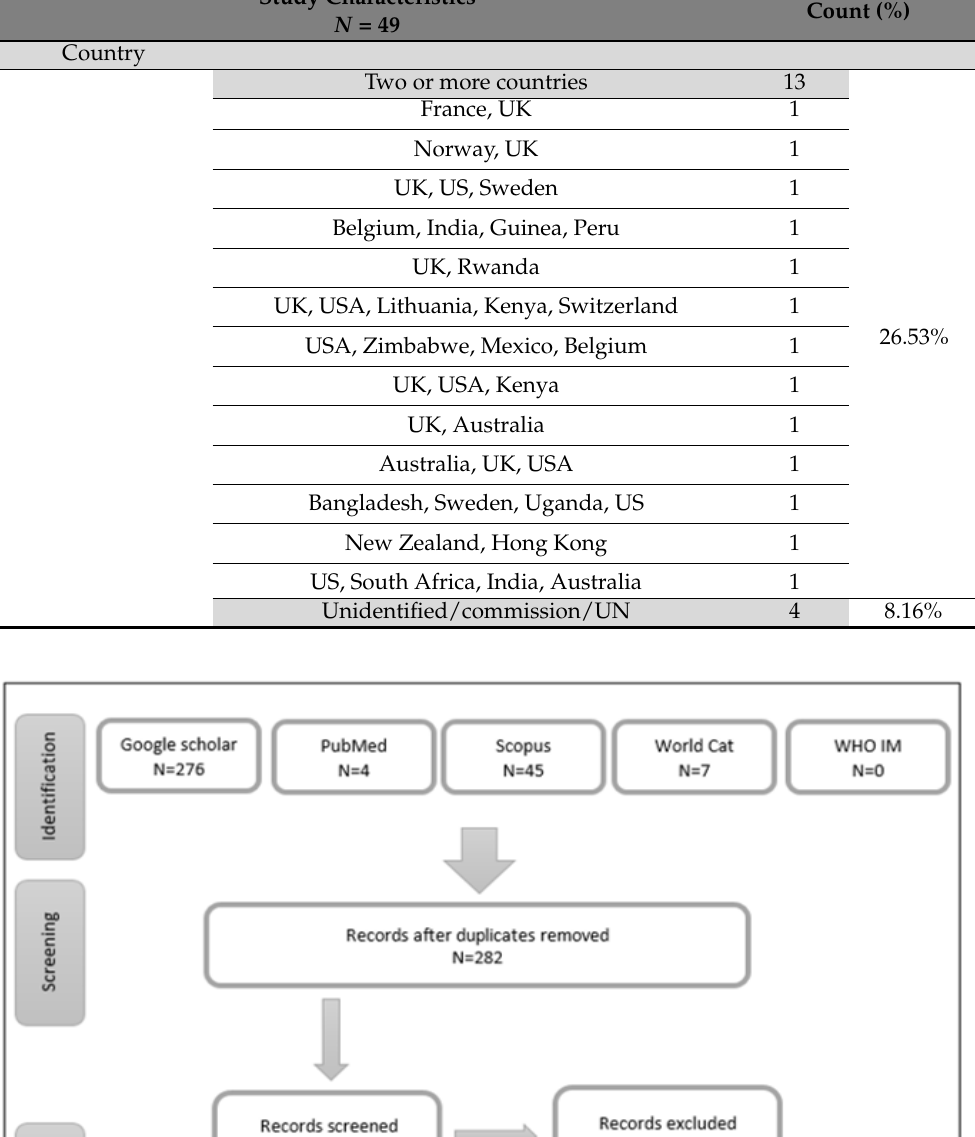
Table 1. Included studies characteristics.